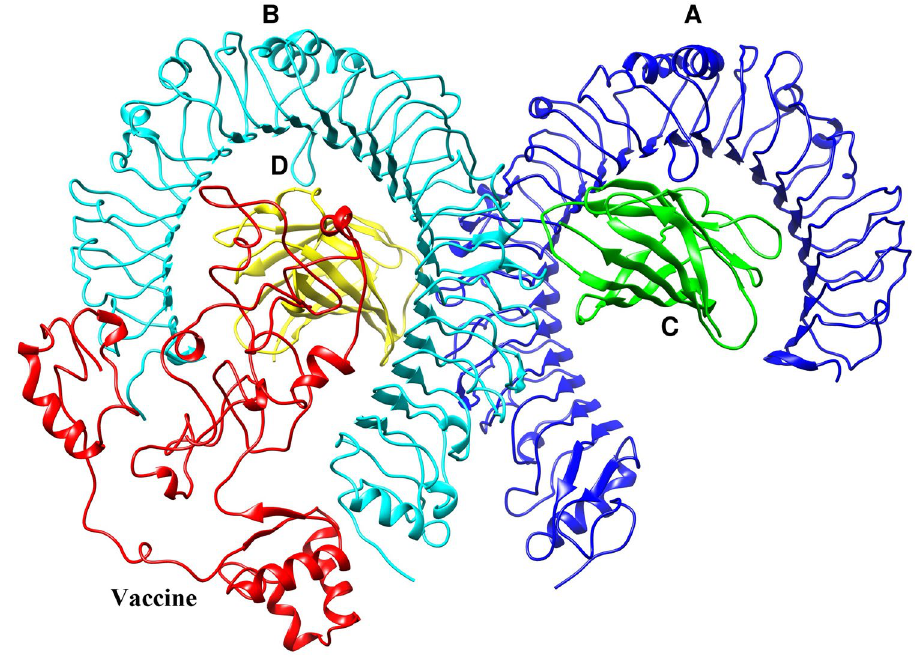
Figure 8. Docked complex of the vaccine construct (ligand) and TLR4 (receptor). Chains A, B, C, and D of TLR4 are shown in blue, cyan, green, and yellow, respectively, while the vaccine construct is shown in